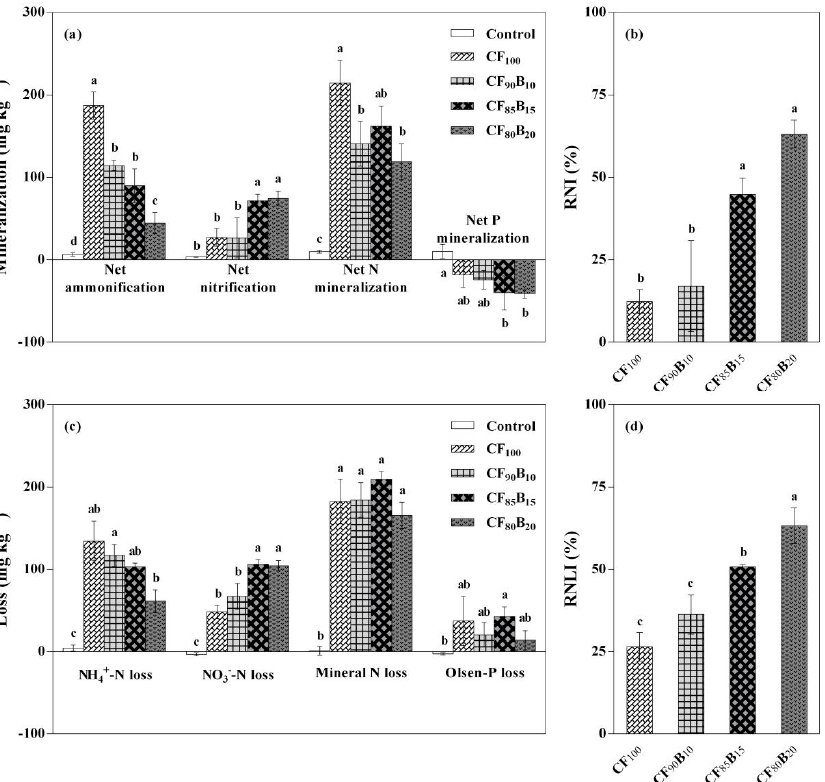
Figure 3. Coupled effects of reduced chemical fertilization and palm silk biochar (PSB) supplementation on net N and P mineralization ( a ), relative nitrification index (RNI) ( b ), mineral N and available P losses ( c ), and relative NO 3 − -N loss index (RNLI) ( d ) in 0–40 cm soil layer. Treatments: Control, no fertilization; CF 100 , 100% conventional fertilization; CF 90 B 10 , 90% conventional fertilization plus 10% PSB-based fertilization; CF 85 B 15 , 85% conventional fertilization plus 15% PSB-based fertilization; CF 80 B 20 , 80% conventional fertilization plus 20% PSB-based fertilization. Data are expressed as means ± SD ( n = 3). For each parameter, bars labeled with different lowercase letters (e.g., a, b, c, etc.) indicate significant ( p < 0.05) differences among the treatments based on the Tukey test or Games–Howell test.